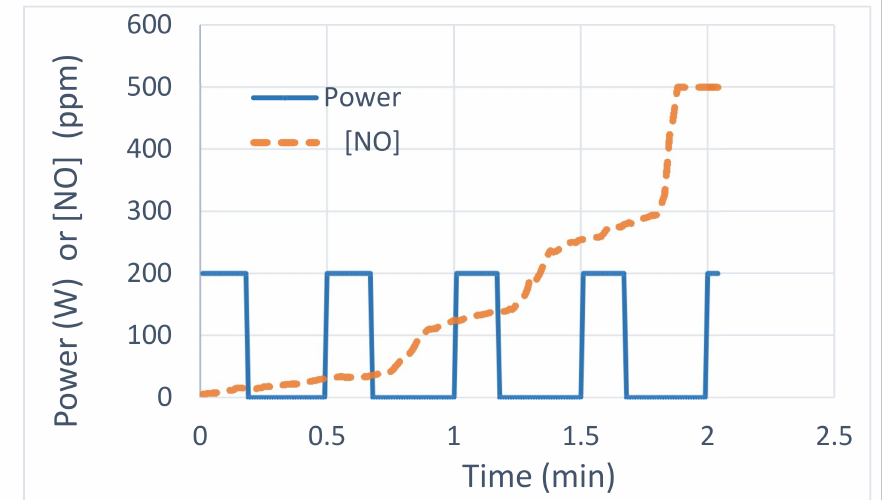
Figure 1. Nitric oxide evolution during intermittent microwave irradiation in air of barium titanate spheres with peak power at 200 W for a period of 10 s and no irradiation for 20 s. Nitric oxide concentration [NO] is measured on-line with maximum detection limit of 500 ppm.